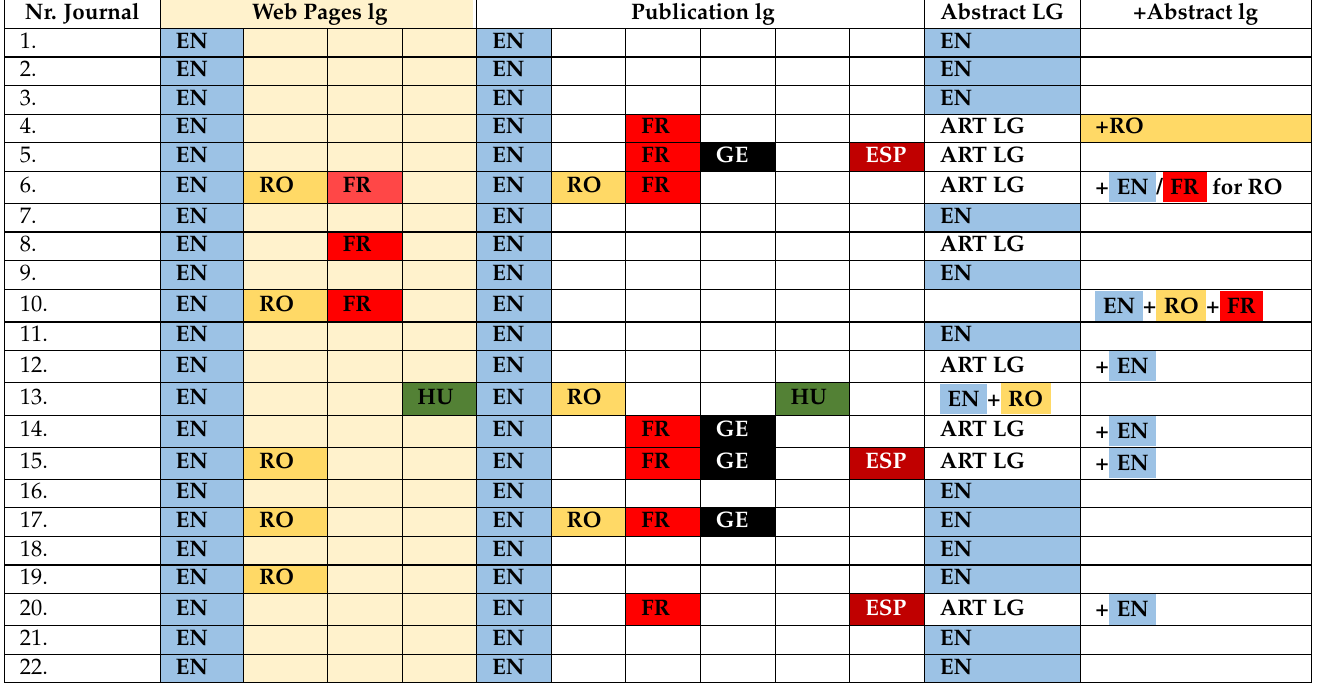
Table 2. Language preferences displayed by the